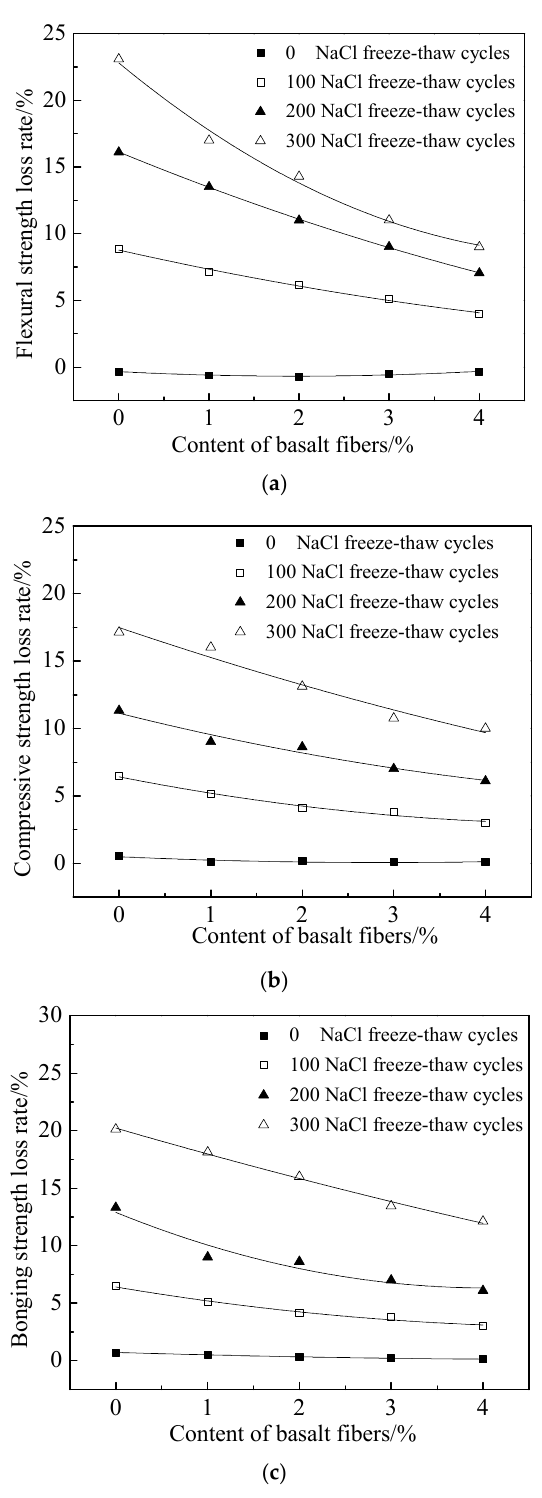
Figure 9. The mechanical strengths loss rate of SAC-RPC under the coupling effect of carbonation and NaCl freeze-thaw cycles, ( a ) The flexural strength loss rate, ( b ) The compressive strength loss rate, ( c ) The bonding strength loss rate.